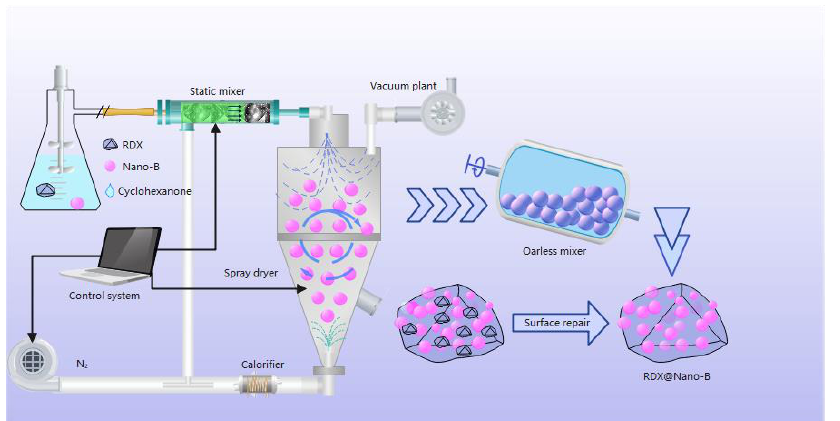
Figure 1. The preparation process of complex RDX@Nano-B .